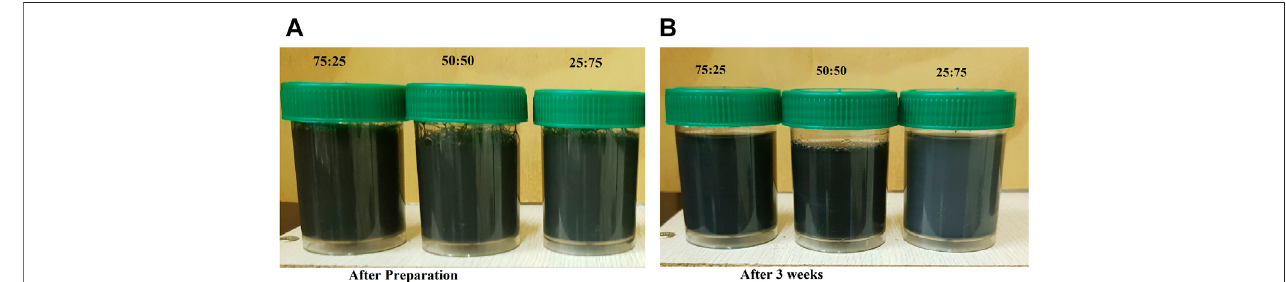
FIGURE 4 | Visual Stability of the hybrid nano fl uids (A) after preparation, and (B) after 3 weeks.